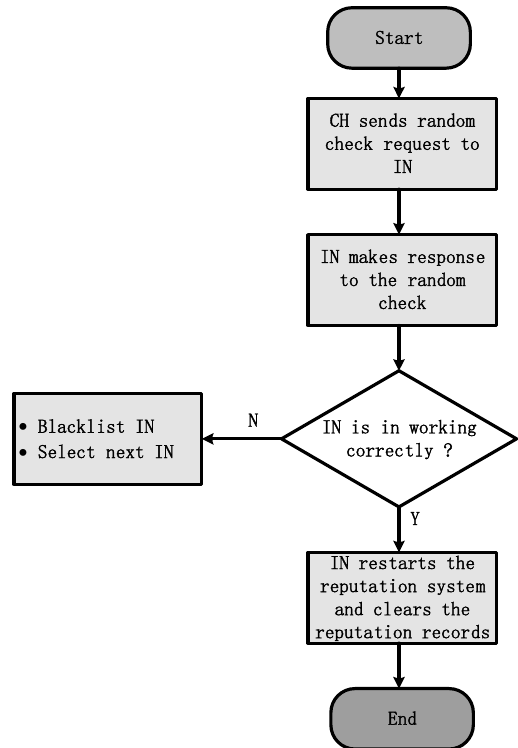
Figure 3. Cluster Head (CH) node checks the Inspecting Node (IN).